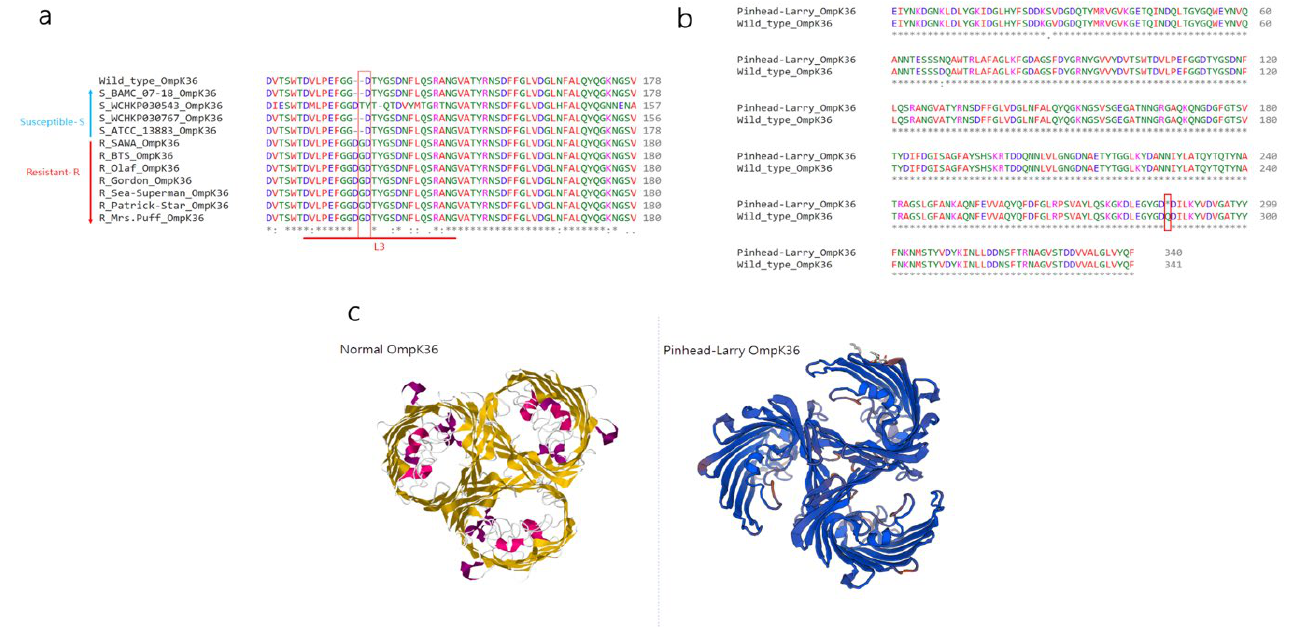
Figure 2. Characterization of a novel stop codon associated with carbapenemase-negative CRKP. The sequence alignment and structure reconstruction of OmpK36 in carbapenemase-negative and carbapenem-resistant K. pneumoniae isolates. ( a ) Multiple sequence alignment of the seven carbapenem-resistant isolates against five public carbapenem-sensitive strains of OmpK36 reveals GD insertion in loop L3. ( b ) Sequence alignment of OmpK36 between the isolate Pinhead-Larry and the K. pneumoniae reference strain reveals a Q309 stop codon. ( c ) Comparison of the protein structures between the wild type and Q309 stop codon OmpK36, providing a visual representation of the structural impact of the stop codon on the protein.